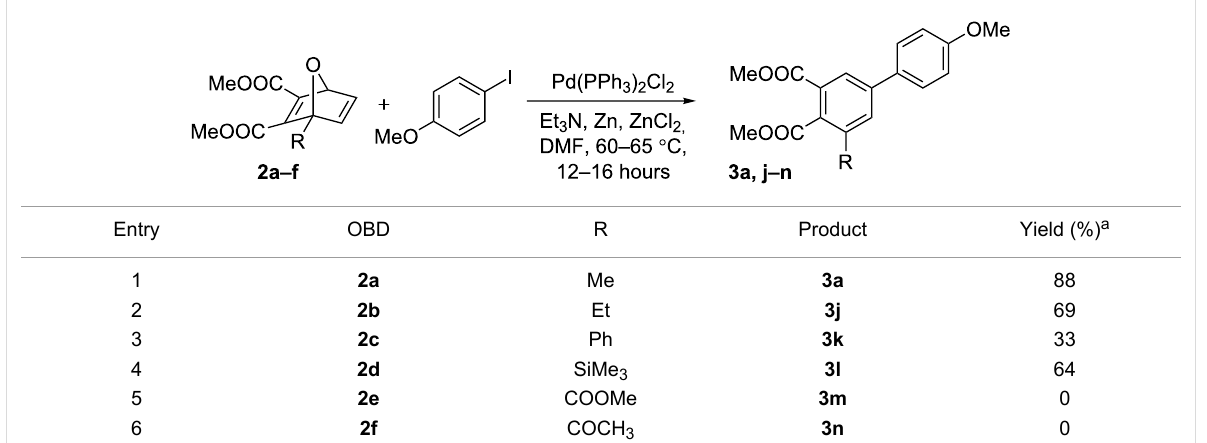
Table 3: Effect of C1 substitution on the ring-opening reaction of